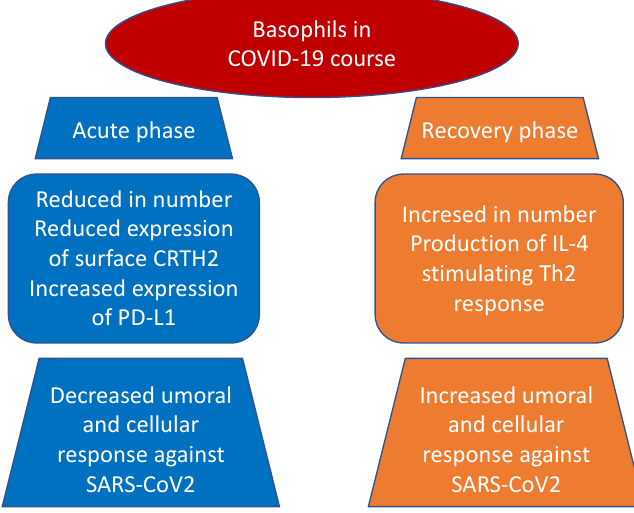
Figure 1. Basophils in COVID-19 pathogenesis .